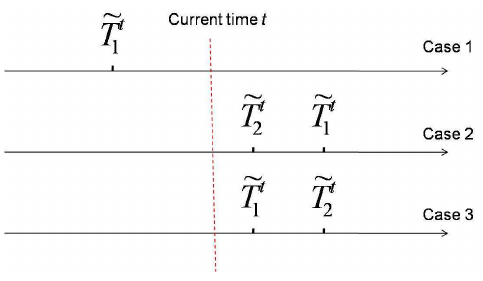
Figure 44. Illustration of three cases in the heuristic decision